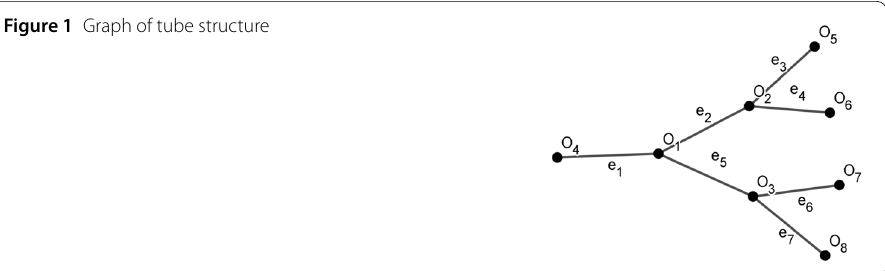
Figure 1 Graph of tube